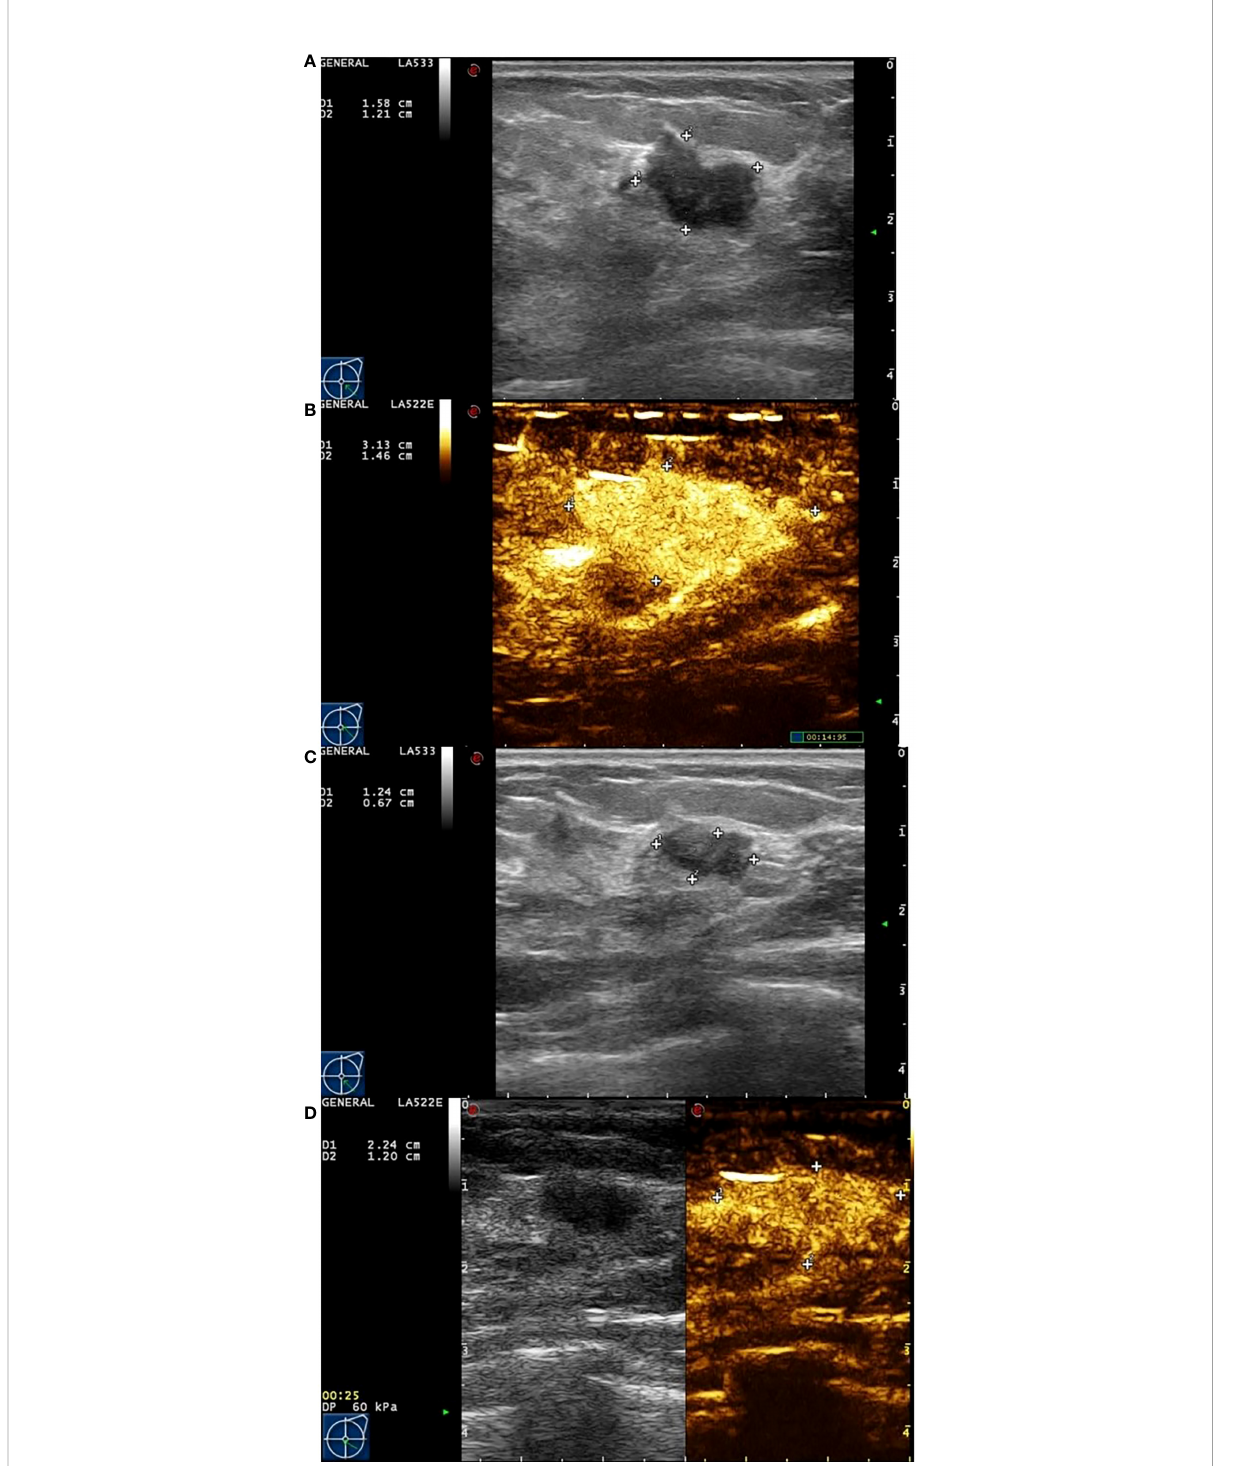
FIGURE 2 Images from a patient of non-response to NAC. (A) At baseline before NAC, the tumor size was measured by ultrasonography. (B) At baseline before NAC, the tumor size was measured by contrast-enhanced ultrasound. The extent of tumor was signi fi cantly larger than that of ultrasonography. (C) After the last cycle of NAC before surgery, the tumor size was measured by ultrasonography. (D) After the last cycle of NAC before surgery, the tumor size was measured by contrast-enhanced ultrasound. Although the extent of tumor has shrunken, there still have large number of contrast agents